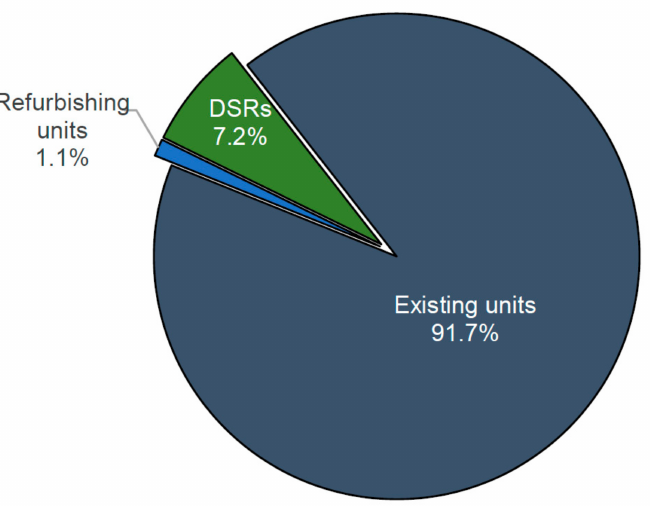
Figure 7. Structure of capacity obligation volumes contracted in main capacity auction for 2022 delivery year–break down by official (declared) assignments to capacity market units. Source: Own analysis based on